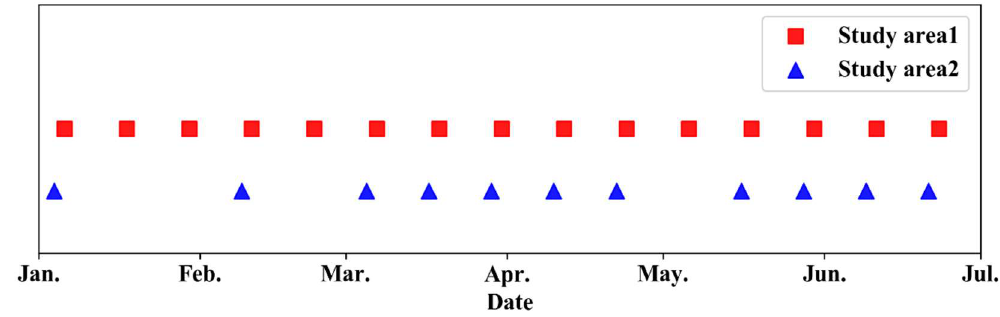
Figure 2. Data acquisition date in two study areas .